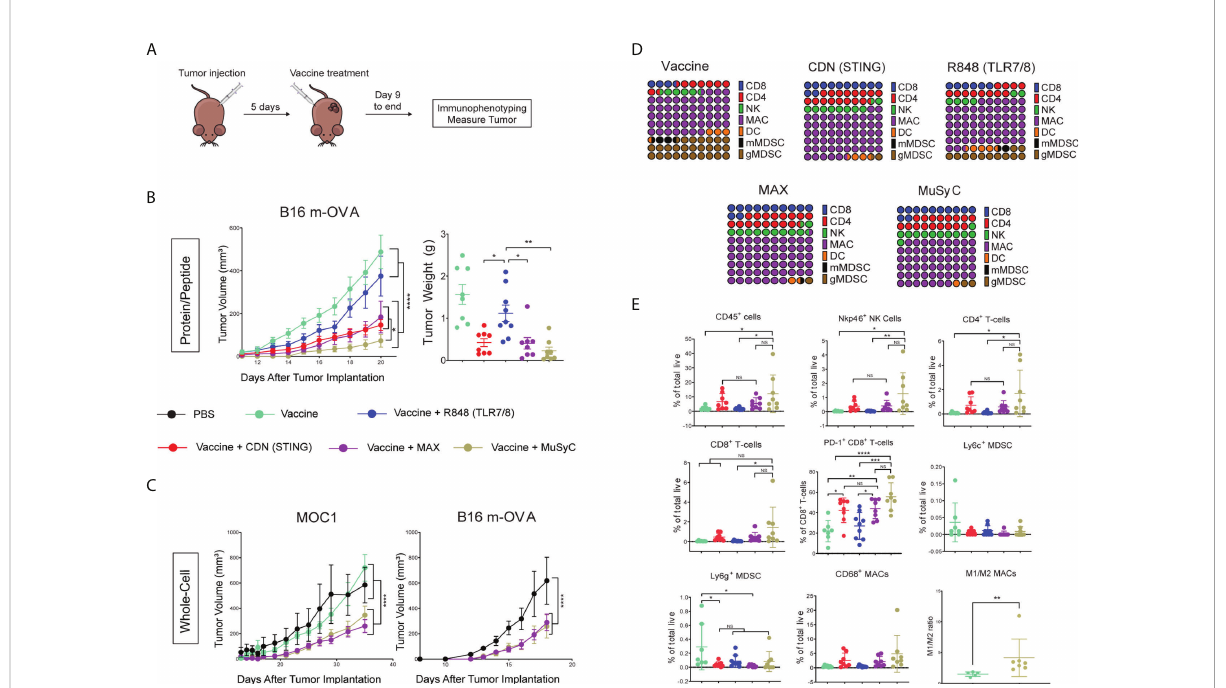
FIGURE 4 MuSyC dosing optimizes the antitumor response in vivo through modulating the tumor microenvironment. (A) General vaccination strategy for tumor models (B) 10 5 B16 m-OVA tumor cells were subcutaneously injected on one fl ank of C57BL/6 mice (n = 10 – 11). Mice were then subcutaneously injected with 20 m g of full-length ovalbumin protein vaccine alone, 20 µg of vaccine administered with 2 m g per mouse R848 (TLR7/8), 20 m g per mouse CDN (STING), Max-dose (R848 of 2 m g per mouse + CDN of 20 µg per mouse), or MuSyC-dose (R848 of 0.2 m g per mouse + CDN of 20 m g per mouse) in the opposite fl ank. B16 m-OVA tumor curve and fi nal day tumor weights are shown. (C) 10 5 B16 m-OVA and 2 × 10 6 MOC1 were subcutaneously injected in one fl ank C57BL/6 mice (n = 8 – 12). Mice were subcutaneously injected with PBS, 10 6 whole-cell vaccine GVAX (B16 m-OVA or MOC1-derived GVAX), and GVAX administered with Max-dose and MuSyC-dose. B16 and MOC1 tumor curves are shown. (D) Percentage of CD45 for the following cell types is shown for B16-moVA peptide vaccination model: NK cells (CD11b-Nkp46+), CD8+ T cells (CD11b-Nkp46-CD4-CD8+), CD4+ T cells (CD11b-Nkp46-CD8-CD4+), gMDSC (CD11b+MHCII-CD68-CD11c- Ly6G+), mMDSC(CD11b+MHCII-CD68-CD11c-Ly6C+), DC (CD68-CD11c+MHCII+), and MACs (CD11c- CD68+). (E) Percentage of total live